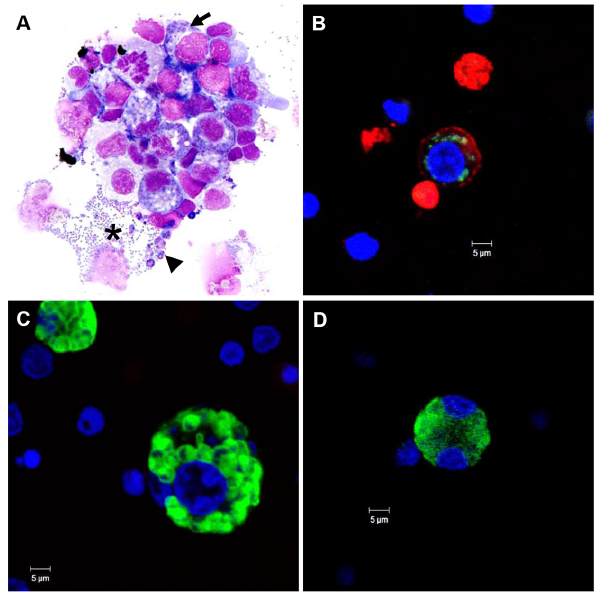
Figure 2. In vitro PBMC infection with T.equi sporozoites. T. equi (Florida strain) infected PBMC day 9-11 in culture; Diff-Quick stained, cytospin preparation (A), and IFA (B, C, and D). (A) Schizont-infected cells have few to abundant, , 0.5–1.0 m m diameter, purple, intracyto- plasmic parasite nuclei (arrow). Adjacent to schizont-infected cells there are several extracellular merozoites (asterix), schizonts (arrowhead), and cellular debris. (B, C and D) IFA images of cells containing different schizont forms are labeled with anti-EMA 1/2 (green). (B) Infected cell is surface labeled with anti-IgM mAb (B lymphocyte). (C, D) Infected cells did not express detectable leukocyte specific surface markers. Nuclei are stained blue with DAPI. signal generated by the leukocyte-specific monoclonal antibodies was unevenly distributed and less abundant on infected cells as